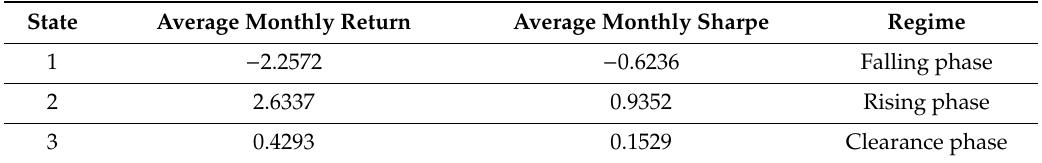
Table 1. Regime Detection by January 2004–December 2005 Optimal state of S&P500 Index. State Average Monthly Return Average Monthly